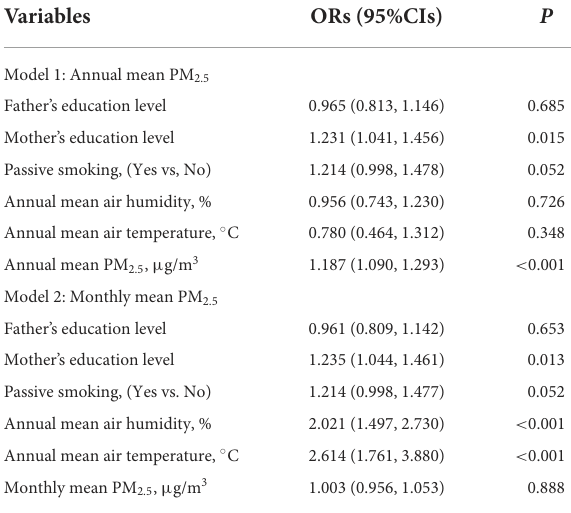
TABLE 5 A multivariate logistic regression model analyzed the association of PM 2.5 with allergic rhinitis risk.